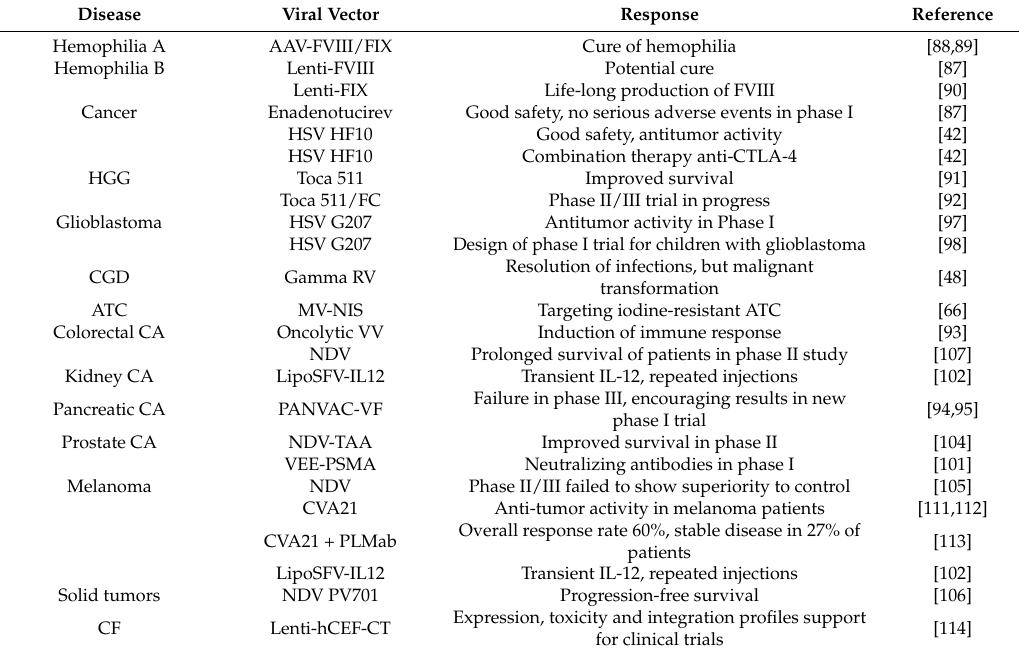
Table 3. Examples of clinical trials using viral